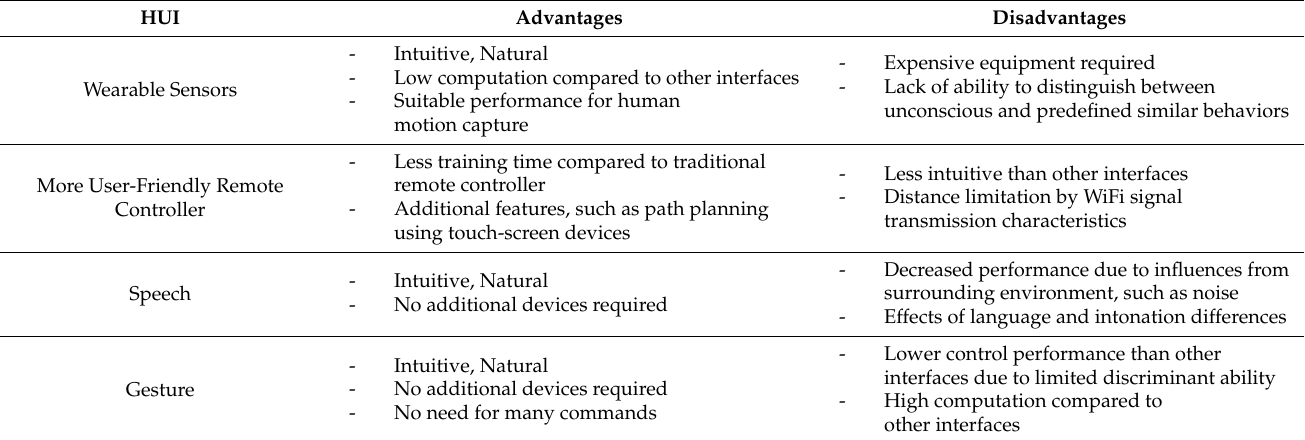
Table 1. Advantages and disadvantages of four types of categories in the